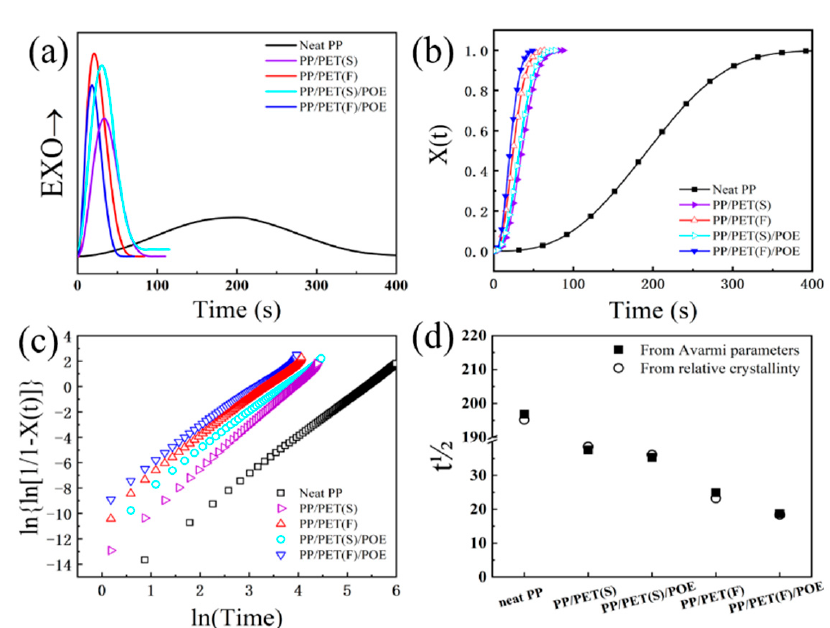
Figure 7. Isothermal crystallization behavior of neat PP, melt-blended and INF composites at 130 ◦ C: ( a ) Isothermal crystallization exotherms as a function of time; ( b ) Relative crystallinity, X(t), as a function of time; ( c ) Isothermal crystallization kinetics analyzed curves; ( d ) Half-time, t1/2, of crystallization determined from the Avrami analysis and the relative crystallinity shown in ( b ).